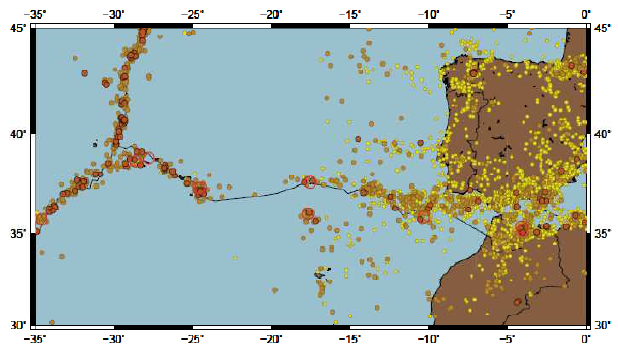
Fig. 1. Seismicity of the western part of the Eurasia-Nubia plate boundary for the period 01/01/1973–17/06/2010 ( M ≥ 3 . 0, USGS Data File). Small yellow circles represent seismic events with 3 ≤ M < 4, small light brown ones correspond to 4 ≤ M < 5, mean orange circles signify 5 ≤ M < 6, and big red hollow circles stand for 6 ≤ M <